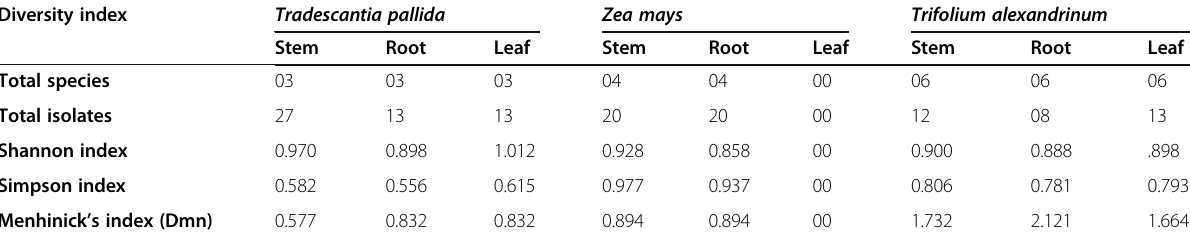
Table 2 Alpha diversity of endophytic fungi Diversity index